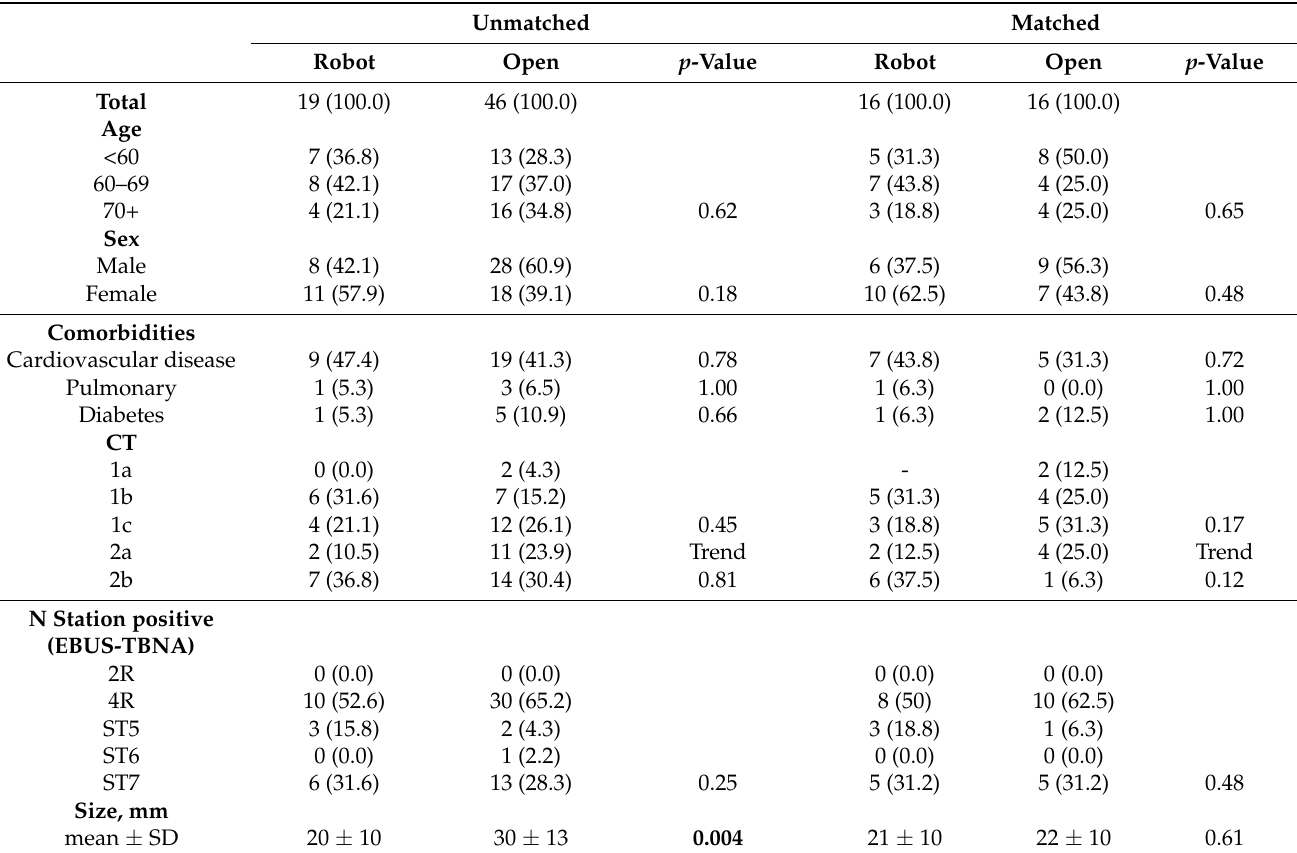
Table 1. Clinical and demographical characteristics of all patients and matched